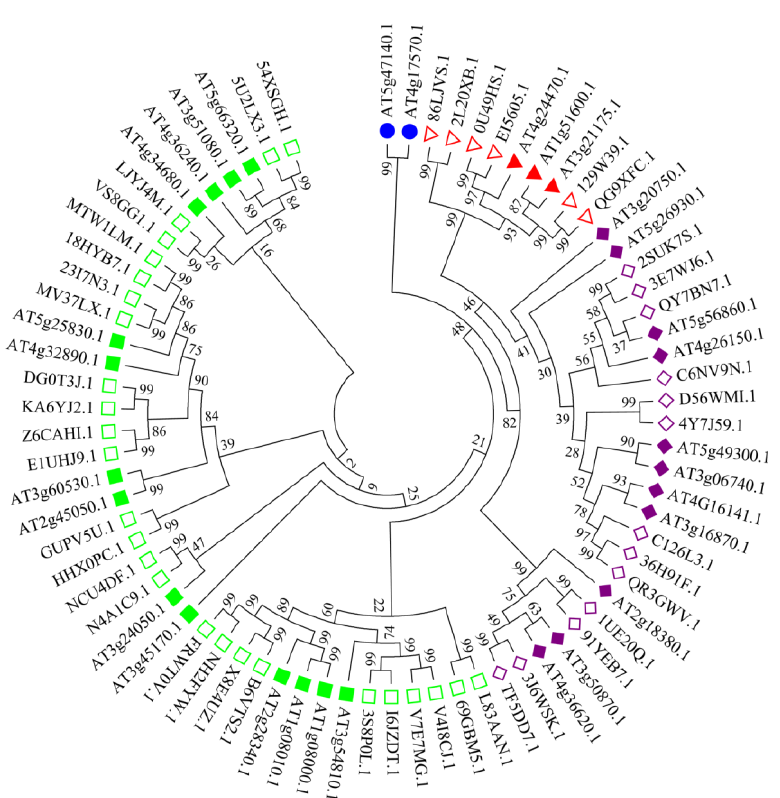
Figure 1. Phylogenetic relationships of GATA proteins from A. thaliana and A. hypogaea L. Green indicates subfamily I. Purple indicates subfamily II. Red indicates subfamily III. Blue indicates subfamily IV. Solid and hollow represent GATA family members in A. thaliana and A. hypogaea L., respectively.